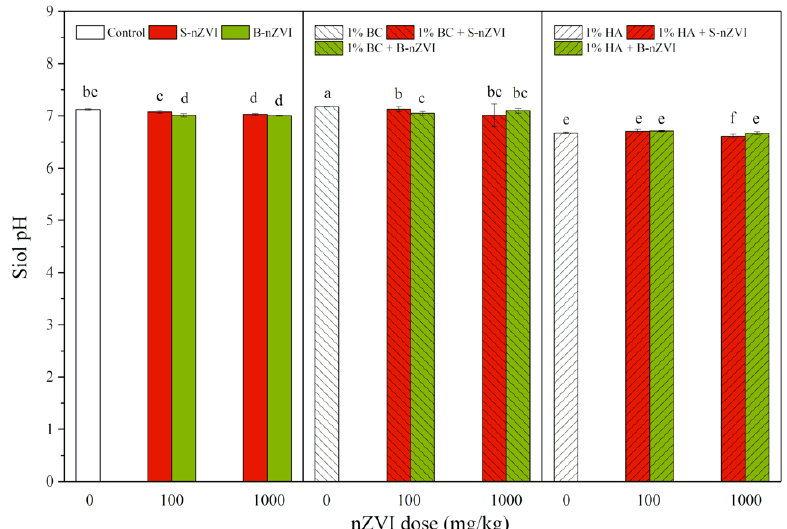
Figure 3. pH value (means ± SD, n = 4) of soil with nZVI alone or in combination with BC or HA. Different letters on the bars indicate significant differences among all means in different treatments using a one-way ANOVA followed by a Duncan’s multiple range test ( p < 0.05). Three-way ANOVA results are shown in Table 2.